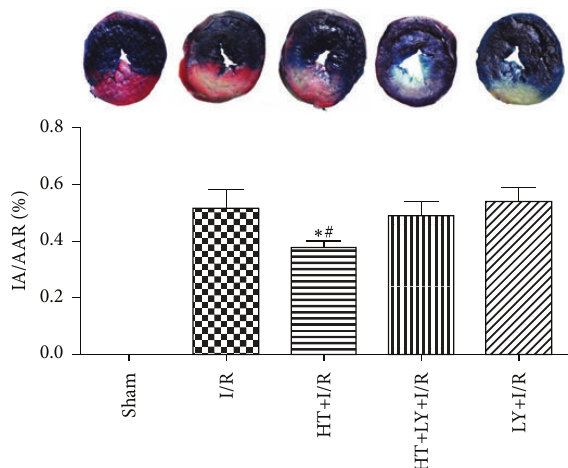
Figure1:EffectsofHTandLY294002(LY)ontheareaofmyocardial infarction ( 𝑛 = 4 for each group). Representative images of TTC and Evans blue dye staining of sections of the heart. Blue, nonrisk area; gray, IA; gray + brick red, AAR. The bar graph represents IA expressed as the percentage of the AAR. Data are presented as mean ± SE. ∗ 𝑃 < 0.05 versus I/R group. # 𝑃 < 0.05 versus HT+LY+I/R